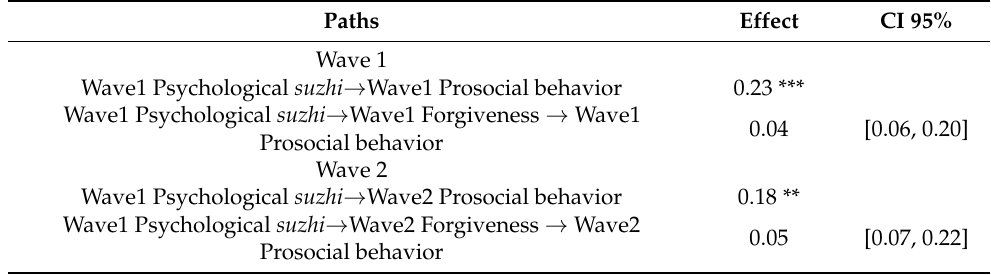
Table 2. The Direct and Indirect Effects of Psychological Suzhi on Prosocial Behavior in Waves 1 and 2.